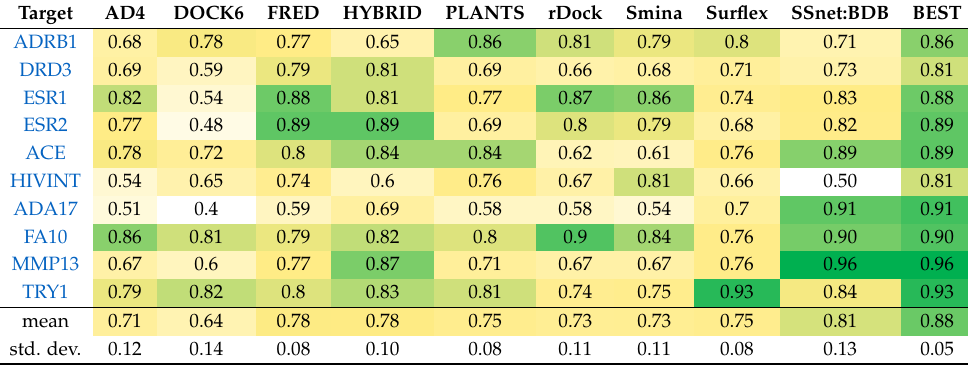
Table 3. AUCROC comparision on various